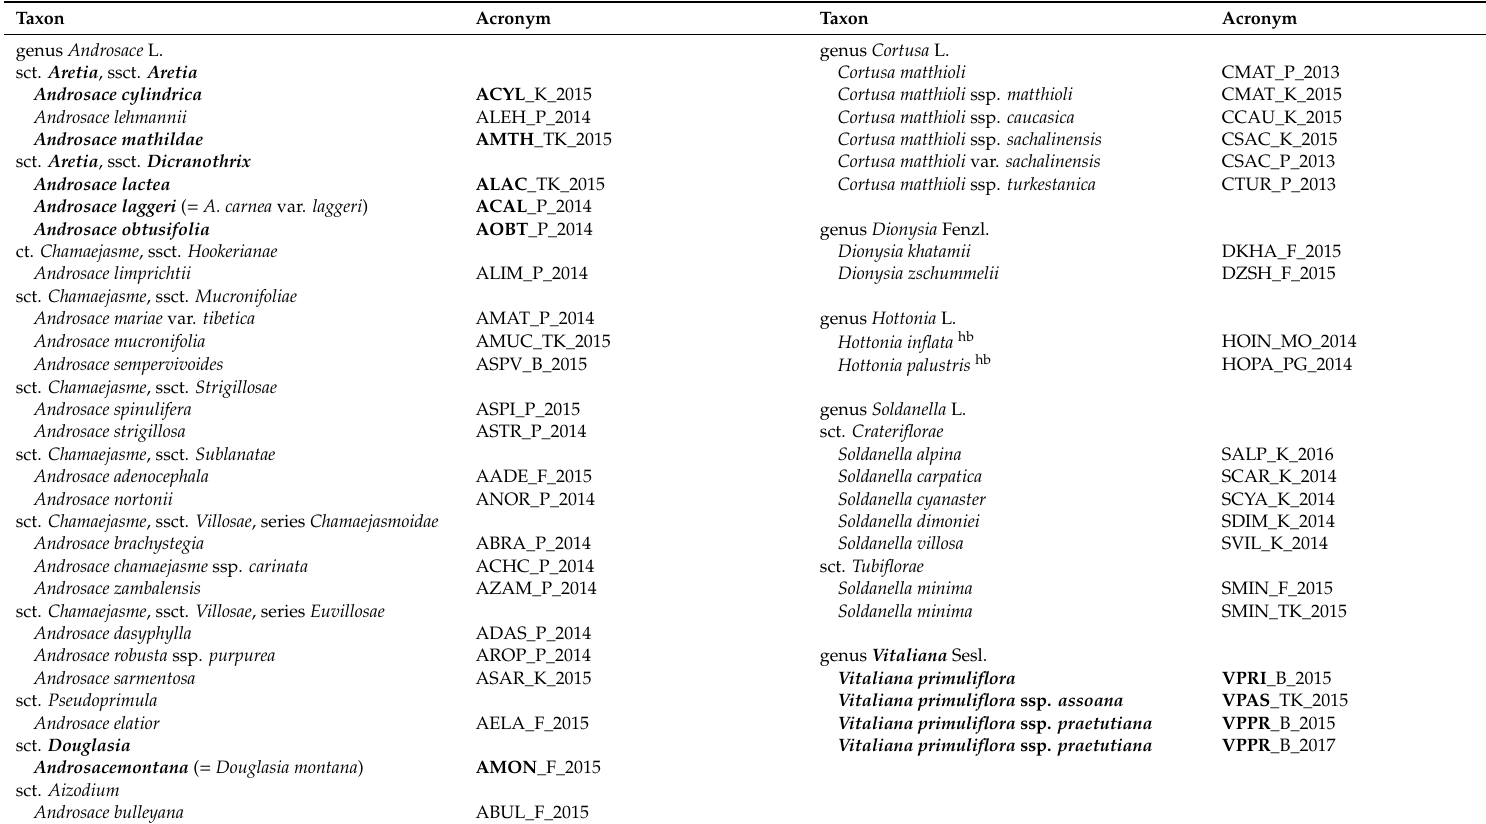
Table A1. The list of Primulaceae species used for UHPLC-MS and -MS / MS screening in this